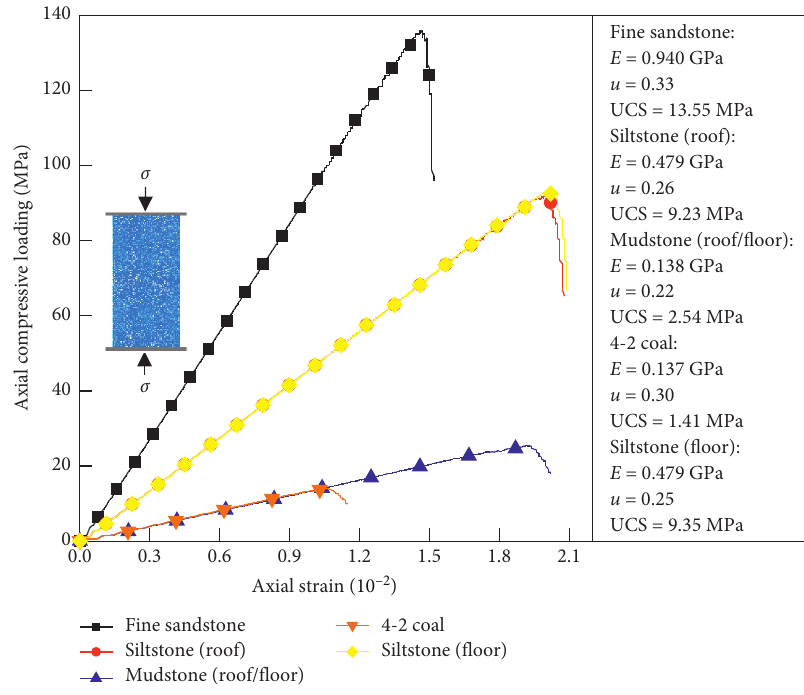
Figure 5: Calibration curve of strength parameters of each rock mass.